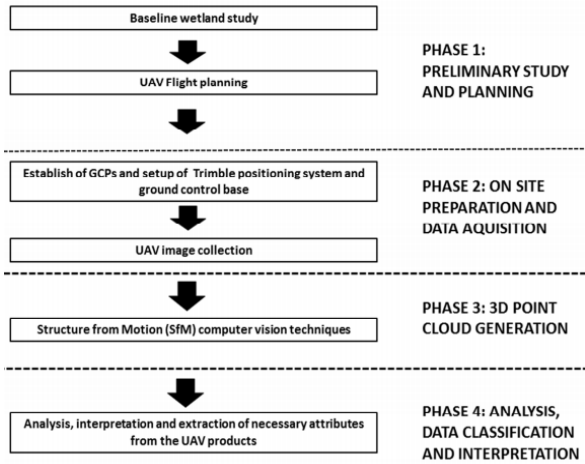
Figure 2. Flow diagram of